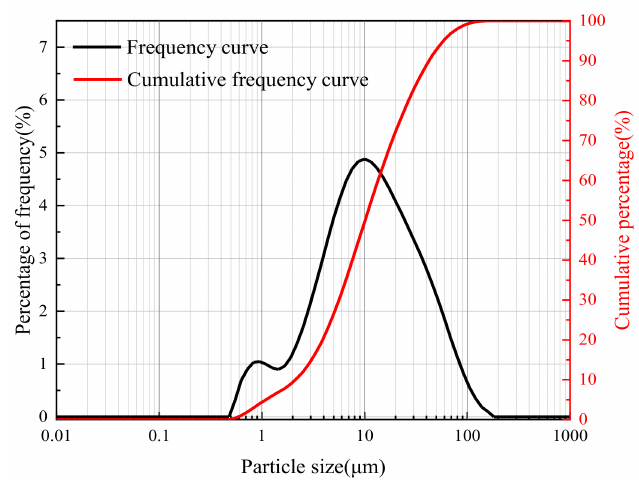
Figure 1. Particle size distribution of tungsten ore flotation wastewater.